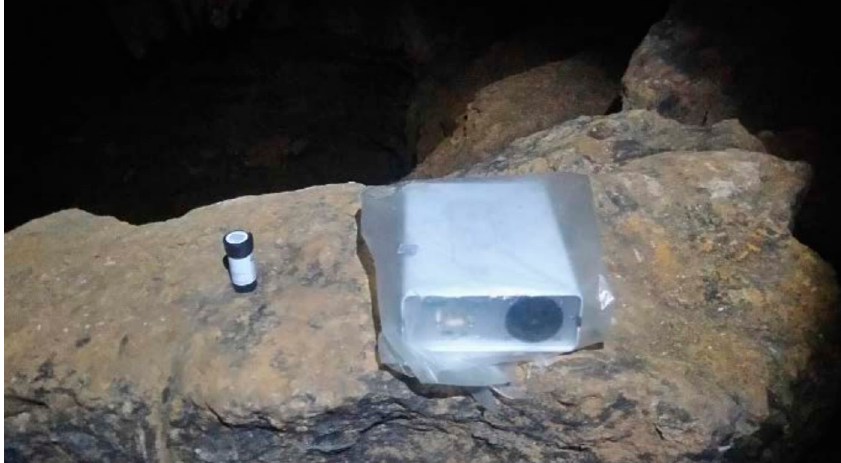
Figure 1. Alpha track detector CR-39 (on the left) and Radon Scout monitor in a plastic bag (on the right).